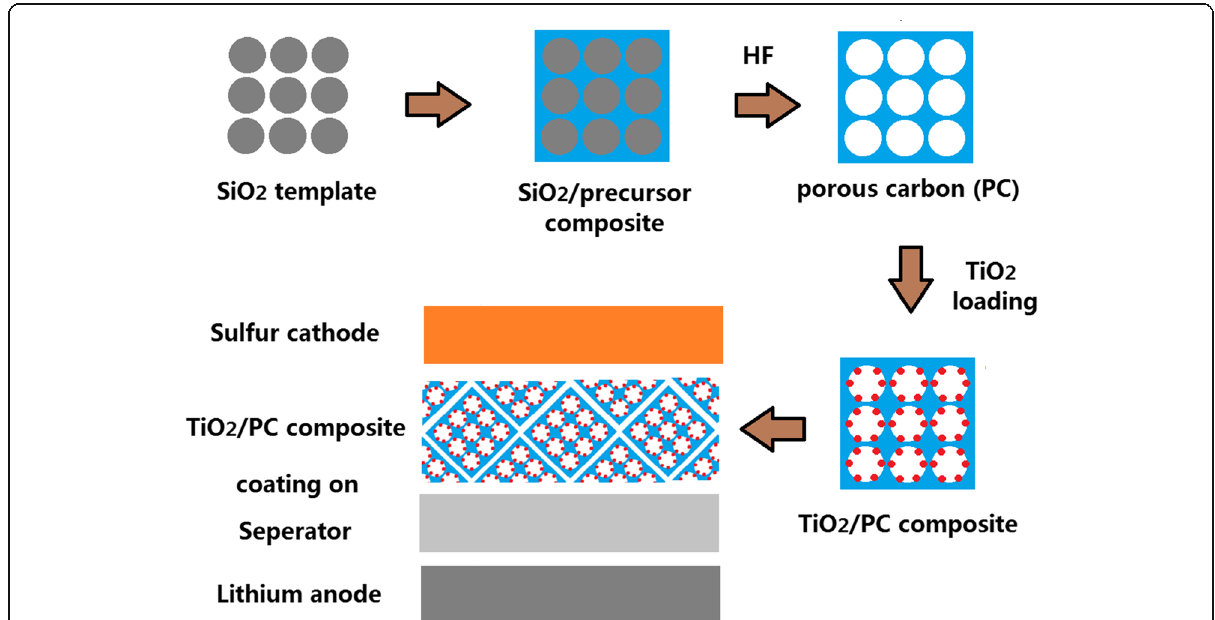
Fig. 1 Synthesis of the TiO 2 /PC-modified Celgard 2400 separator for the Li/S